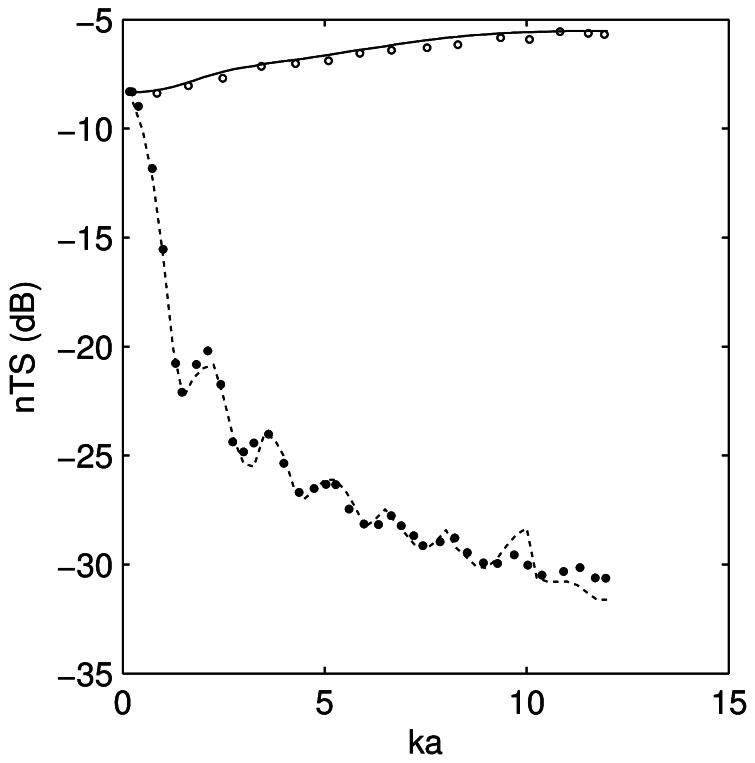
Comparison of prolate-spheroid-modal-series model to published results.Length-normalised target strength (nTS) of a pressure release prolate spheroid with aspect ratio (width/length) of 0.15 at broadside as a function of ka from the prolate-spheroid-modal-series model (solid line) and digitised from Figure 3 of Furusawa [10] (open circles). A similar comparison for end-on backscatter is also shown (dashed line from the prolate-spheroid-modal-series model and closed circles from Figure 3 of Furusawa [10]).